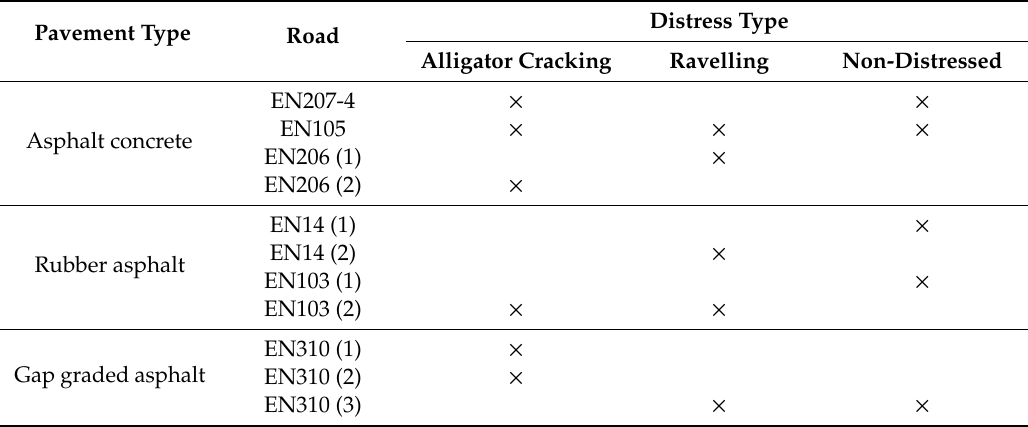
Table A2. Roads where measurements were